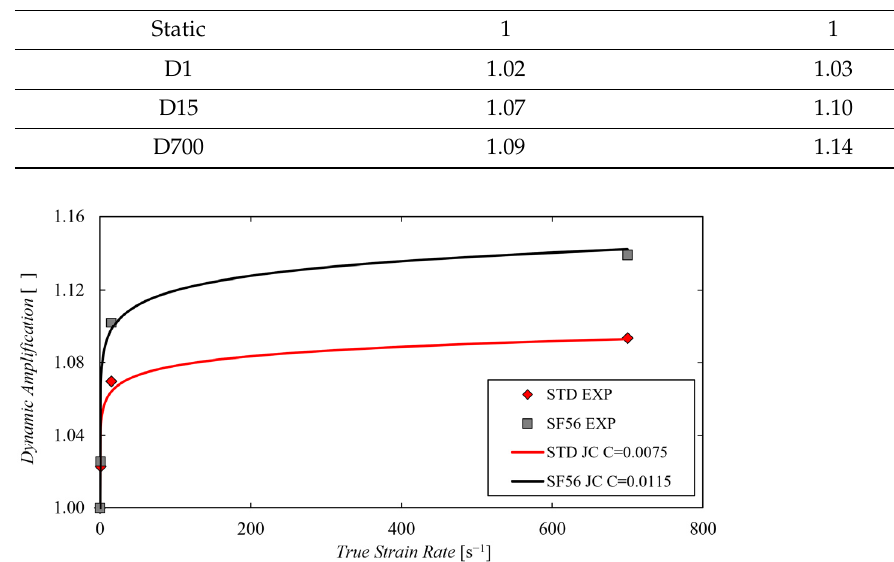
Table 3. Experimental Dynamic amplification R .